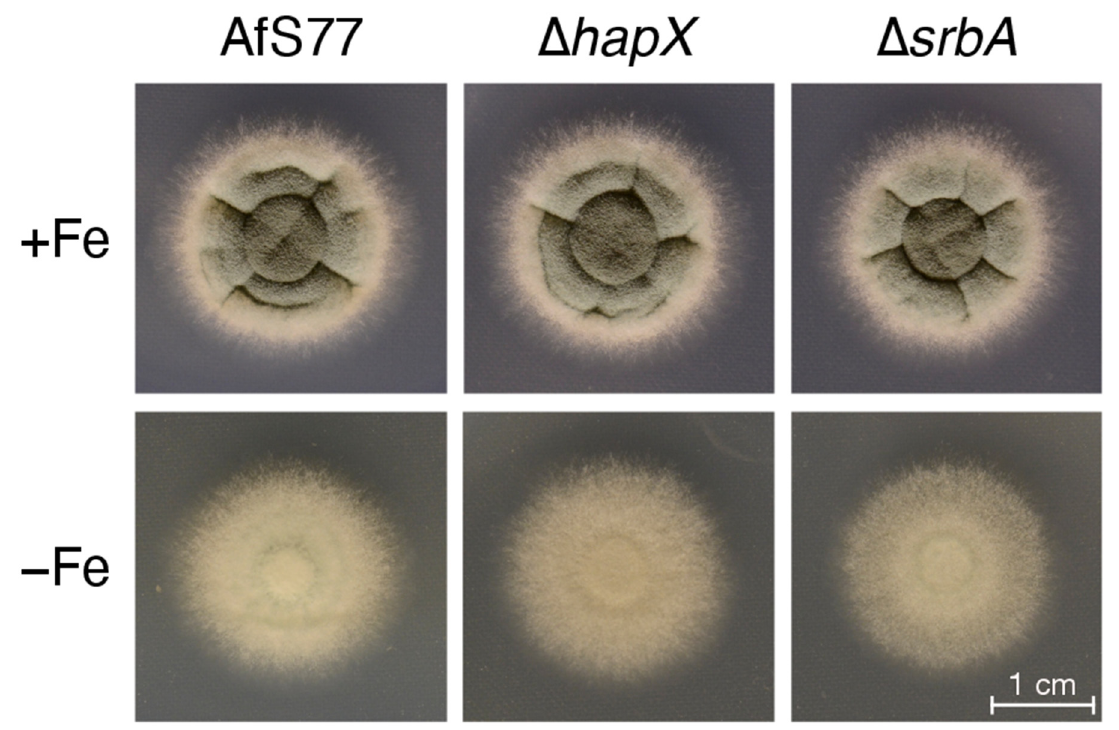
Figure 9. Colony morphology of A. fumigatus AfS77 compared to ∆ hapX and ∆ srbA cultured for 48 h at 37 ◦ C under +Fe and − Fe conditions. For inoculation of fungal strains, suspensions containing 10 4 spores were dotted onto minimal media solidified with 1.5%